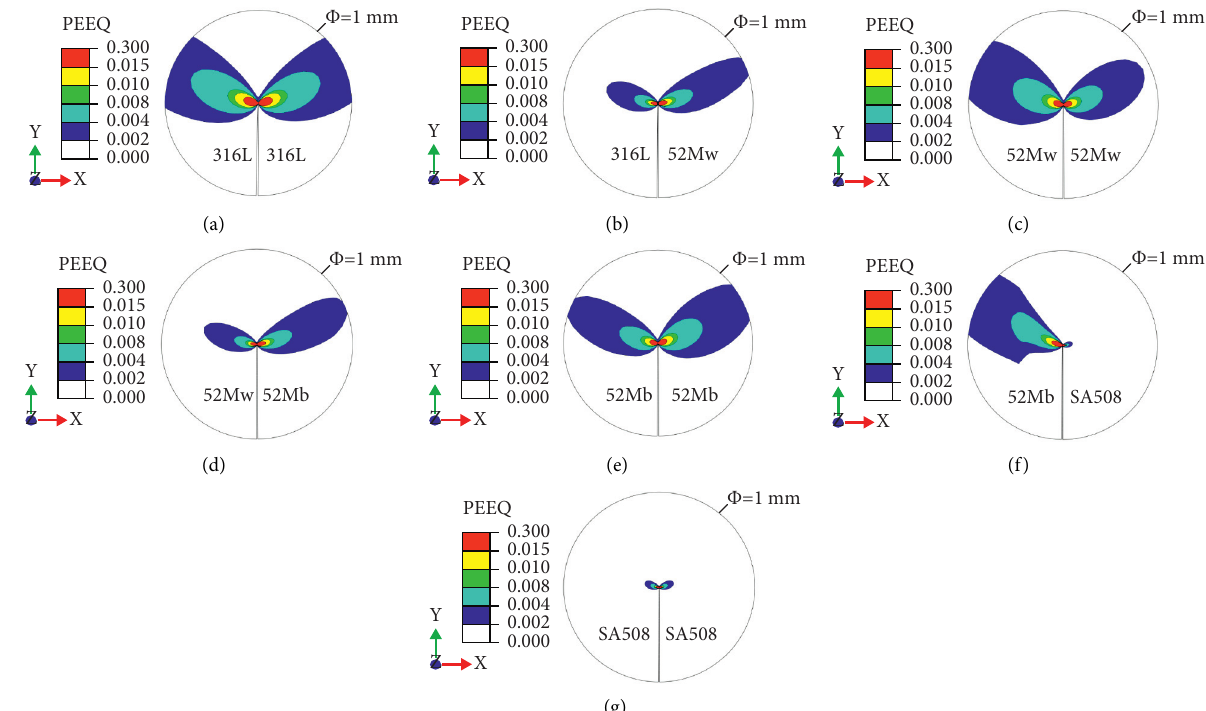
Figure 9: The equivalent plastic strain ε eq contour around the crack tip. (a) Crack 1. (b) Crack 2. (c) Crack 3. (d) Crack 4. (e) Crack 5. (f) Crack 6. (g) Crack 7.